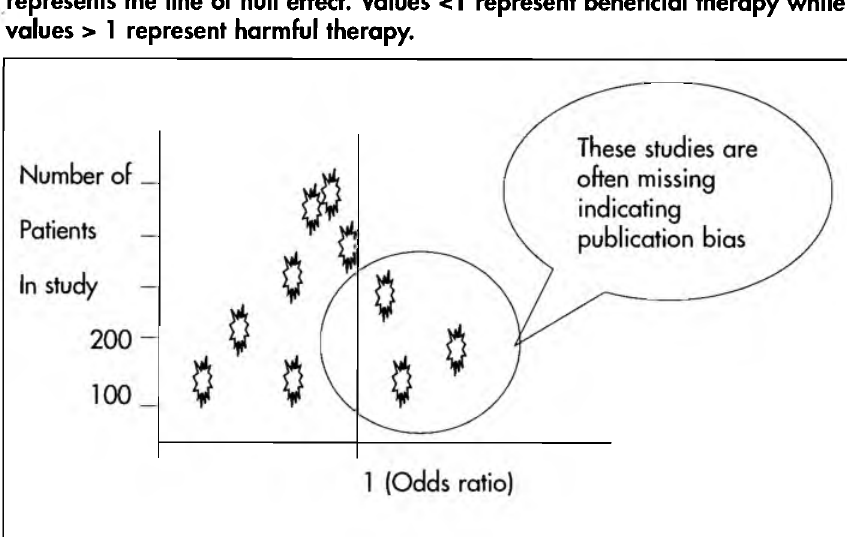
FIGURE 1: The funnel plot for assessing publication bias. An odds ratio of one represents the line of null effect. Values <1 represent beneficial therapy while values > 1 represent harmful